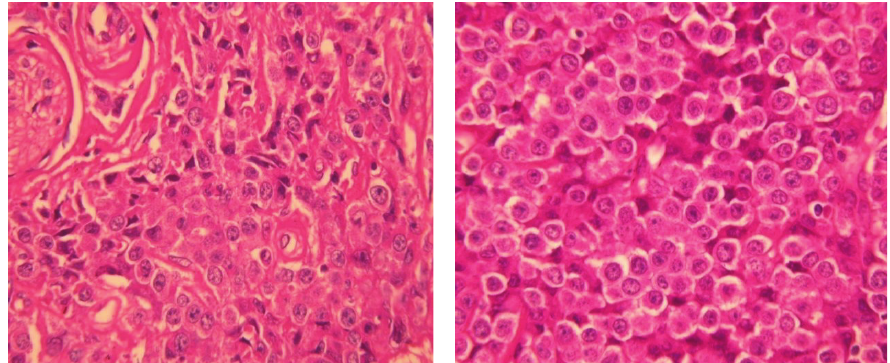
Figure 6: Biopsy of mass in the pancreatic head, neoplastic cell infiltration similar to skin biopsy findings.